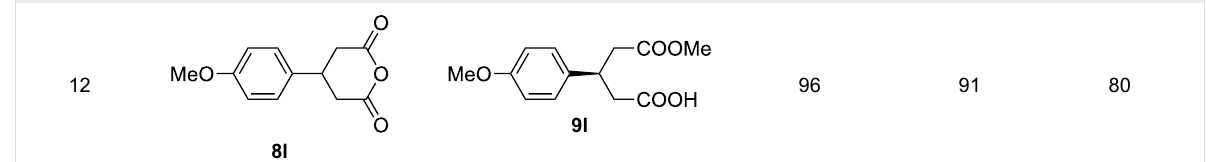
Table 2: Asymmetric methanolysis of meso -cyclic anhydrides. a,b . (continued)